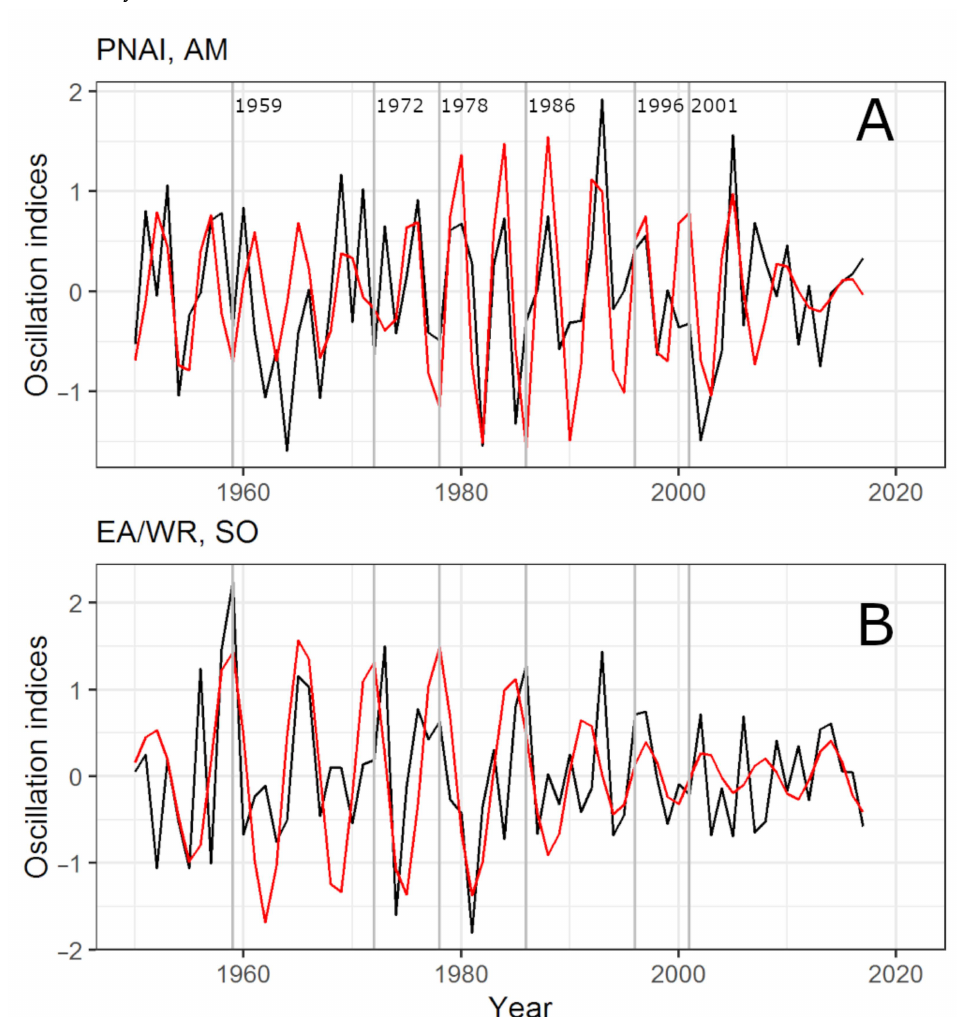
Figure 6. Examples of temporal instability of relationship between oscillations (( A )—Pacific/North America index, ( B )—East Atlantic/Western Russia pattern) and outbreaks. Black line—averaged April–May oscillation indices; red line—reconstructed oscillation indices series for period 4 to 10 years (computed by reconstruct function from package WaveletComp 1.1 [52]), and gray vertical lines—starting years of outbreaks except for 1949 (can not be detected by